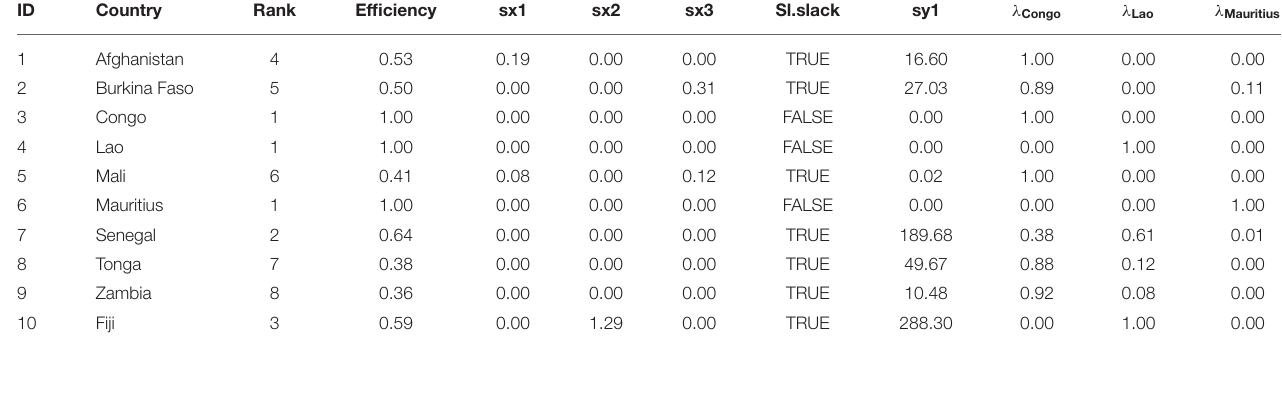
TABLE 3 | Results of the BCC model for Cluster 1 (SIDS and LDC).